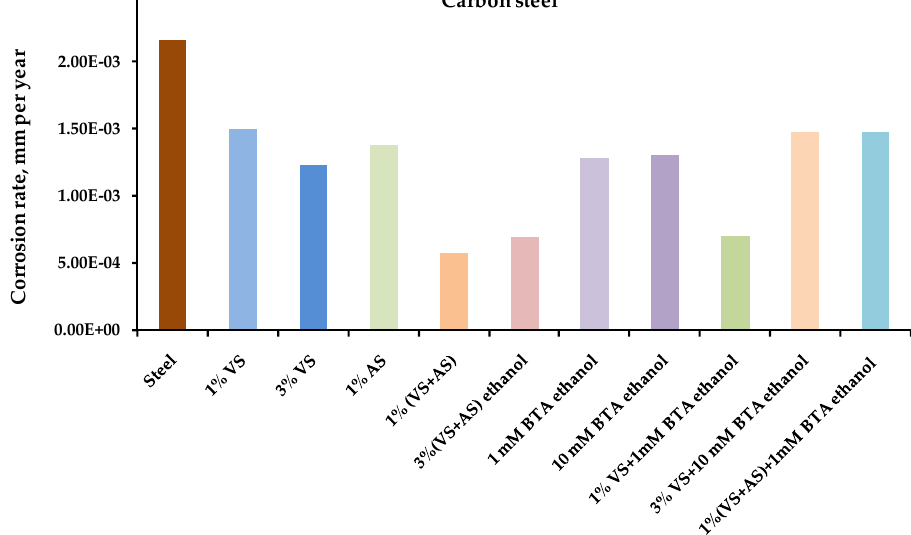
Figure 1. Atmospheric corrosion rates (mm per year) of carbon steel modified by organosilane-based compositions. Full-scale, one-year corrosion tests, carried out in an urban atmosphere. Gravimetric assessment of corrosion magnitude.